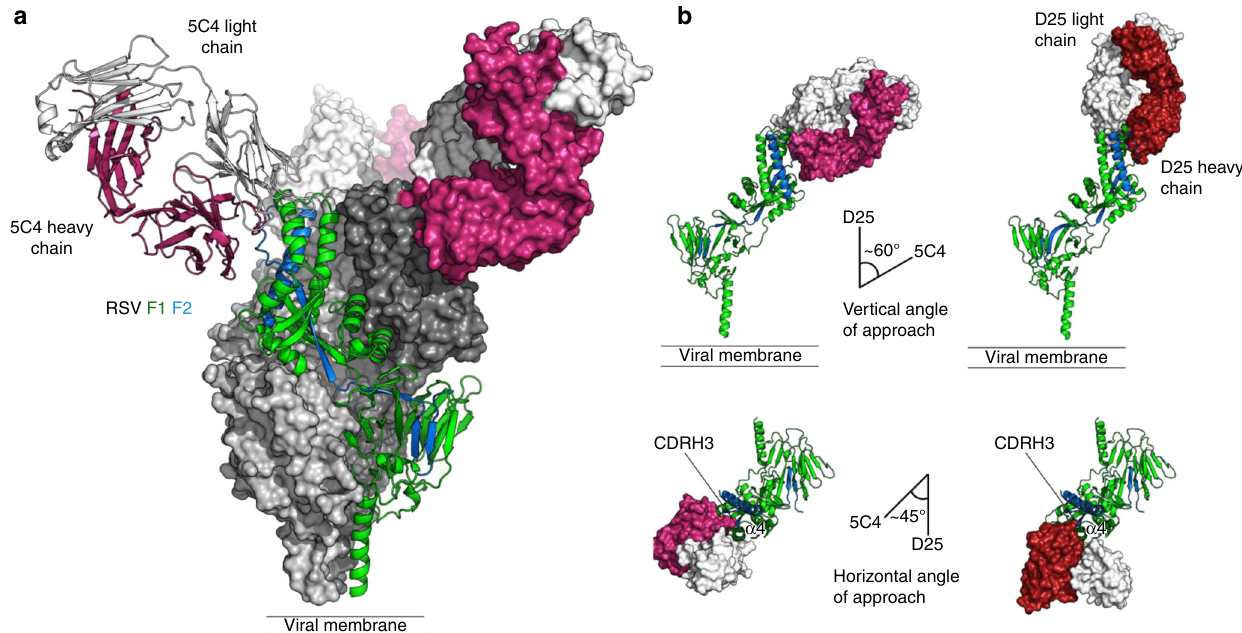
Fig. 2 Mode of 5C4 binding to antigenic site Ø is similar to that of D25. a 5C4 – RSV F complex crystal structure in ribbon and molecular surface representation. Two pre-F protomers are shown as dark and light gray surfaces, and the third protomer is shown as ribbons with F1 colored green and F2 colored blue. The 5C4 Fab bound to the F protomer is also displayed in ribbon representation, with the heavy chain colored pink and the light chain colored white. The other 5C4 Fabs are colored similarly but shown in surface representation. b RSV F protomers are shown in ribbon representation and colored as above. Fabs (upper) and antibody variable domains (lower) are shown as a molecular surface with light chains colored white and the heavy chains of 5C4 and D25 colored pink and red, respectively. The difference in vertical (upper) and horizontal (lower) angle of approach between 5C4 and D25 is represented as intersecting lines with a measured angle of ~ 60° and ~ 45°,